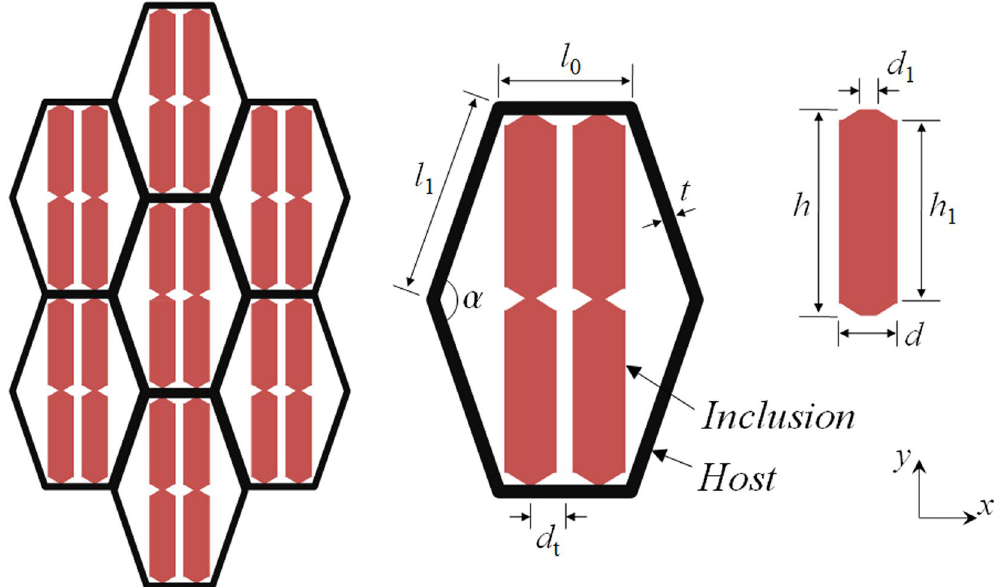
Figure 2. Realistic model of the dual-anisotropic structured material. The model consists of a periodic hexagonal lattice as the host, governing the overall anisotropic stiffness, and two bars as the inclusion, achieving the anisotropic inertial density. Slender cross-sections are made at both the middle and two ends of bars in order to simulate the sliding boundary in fluid-solid interfaces, meanwhile keep the structure mechanically stable. Structural parameters are l 0 = 2 l 1 /3 = 8 t = 10 mm and α = 140° for the lattice host, and d = 10 d 1 = 4 mm, d t = 2.15 mm, and h 1 = 0.8 h for the